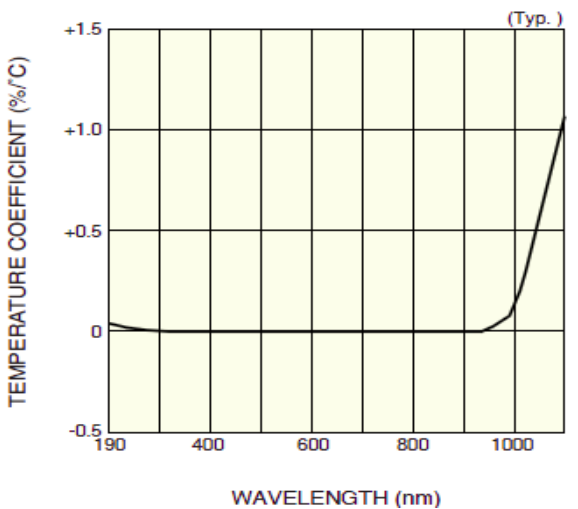
Fig. 1 Temperature effect of S1336 series silicon photodiode from the manufacture (http://www.hamamatsu.com.cn).